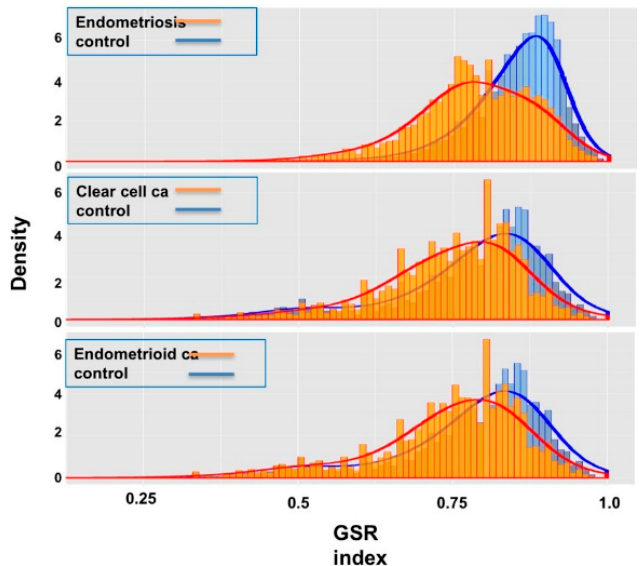
Figure 2. Histograms of the gene set regularity indices for the three diseases and control groups. The figures show the distributions of gene set regularity (GSR) indices from the three diseases (orange) and control groups (blue). The control group for CCC and EC is identical.